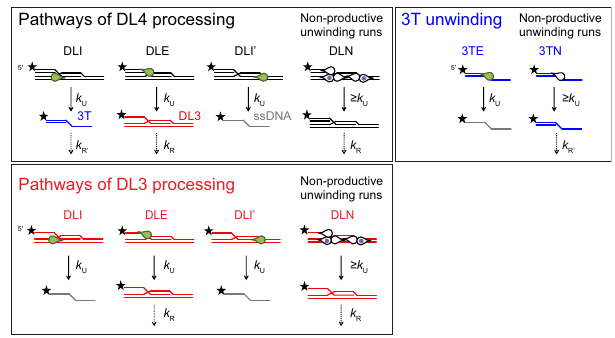
Fig. 3 Kinetic pathways of processing of DL4, DL3, and 3T DNA substrates. The model has been described previously in Harami et al. 19 and is summarized as follows. Fluorescently-labeled D-loop-like (4-stranded DL4, or 3-stranded DL3), 3 ′ -tailed (3T) dsDNA, and ssDNA structures are colored black, red, blue, and gray, respectively. DNA-bound helicases are shown as green drops pointing toward the direction of unwinding (3 ′ – 5 ′ on the tracked DNA strand). Black stars represent the Cy3 fl uorescent label at the 5 ′ end of the invading DNA strand. Enzyme – DNA complexes are initially distributed into different con fi gurations (DLI, DLE, DLI ′ , DLN, 3TE, and 3TN). For DLI, enzyme – DL4 or DL3 complexes are oriented for disruption of the invasion, producing 3T from DL4 or ssDNA from DL3. For DLE, the enzyme is oriented “ outward ” from the invasion and will produce DL3 from DL4 — or in the case of DL3 substrate, leave the substrate intact. For DLI ′ , the enzyme tracks the invading strand starting from its 3 ′ end, thus producing ssDNA from either DL4 or DL3. DLN and 3TN represent all nonproductive unwinding runs starting from any possible enzyme – DNA con fi guration (white drops). Importantly, DLN also includes the fraction of proteins bound in orientations favoring unwinding of the D-loop dsDNA arms (indicated by purple dots). Even successful unwinding of these arms will be nonproductive due to rapid reannealing of the unwound DNA strand. Unwinding (occurring at rate constant k U ) leads to the indicated DNA products. Slow rebinding of the enzyme to these DNA products (inhibited by excess I-trap ssDNA trap strand, occurring at k R for DL4 and DL3, or k R ′ for 3T) leads to reformation of enzyme – DNA con fi gurations (with the same distribution as for the initial complexes; reformation and redistribution together are indicated by downward arrows labeled k R and k R ′ ). These pathways and associated rates form the basis of the kinetic model that is used to fi t the data, e.g., in Figs. 2c,